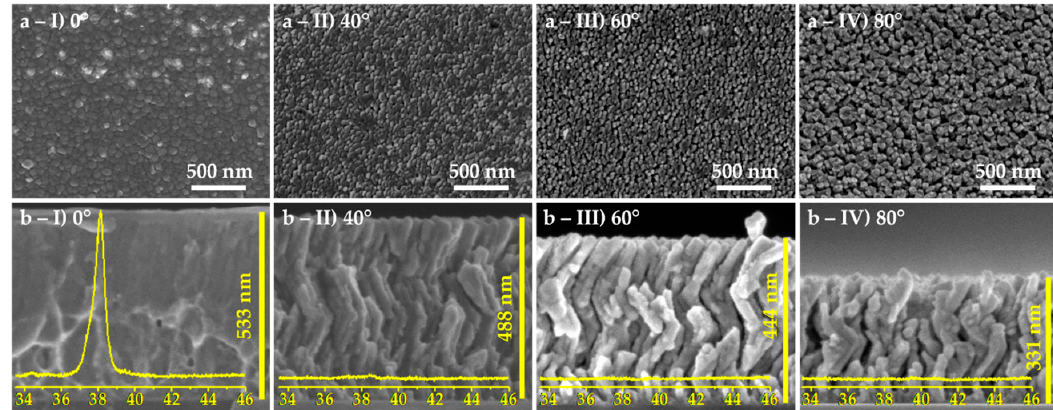
Figure 3. Scanning electron microscopy images of the thin films: ( a ) top-view and ( b ) cross-section micrographs, and the corresponding X-ray diffractograms for the different incidence angles, I) 0°, II) 40°, III) 60°, and IV) 80°.